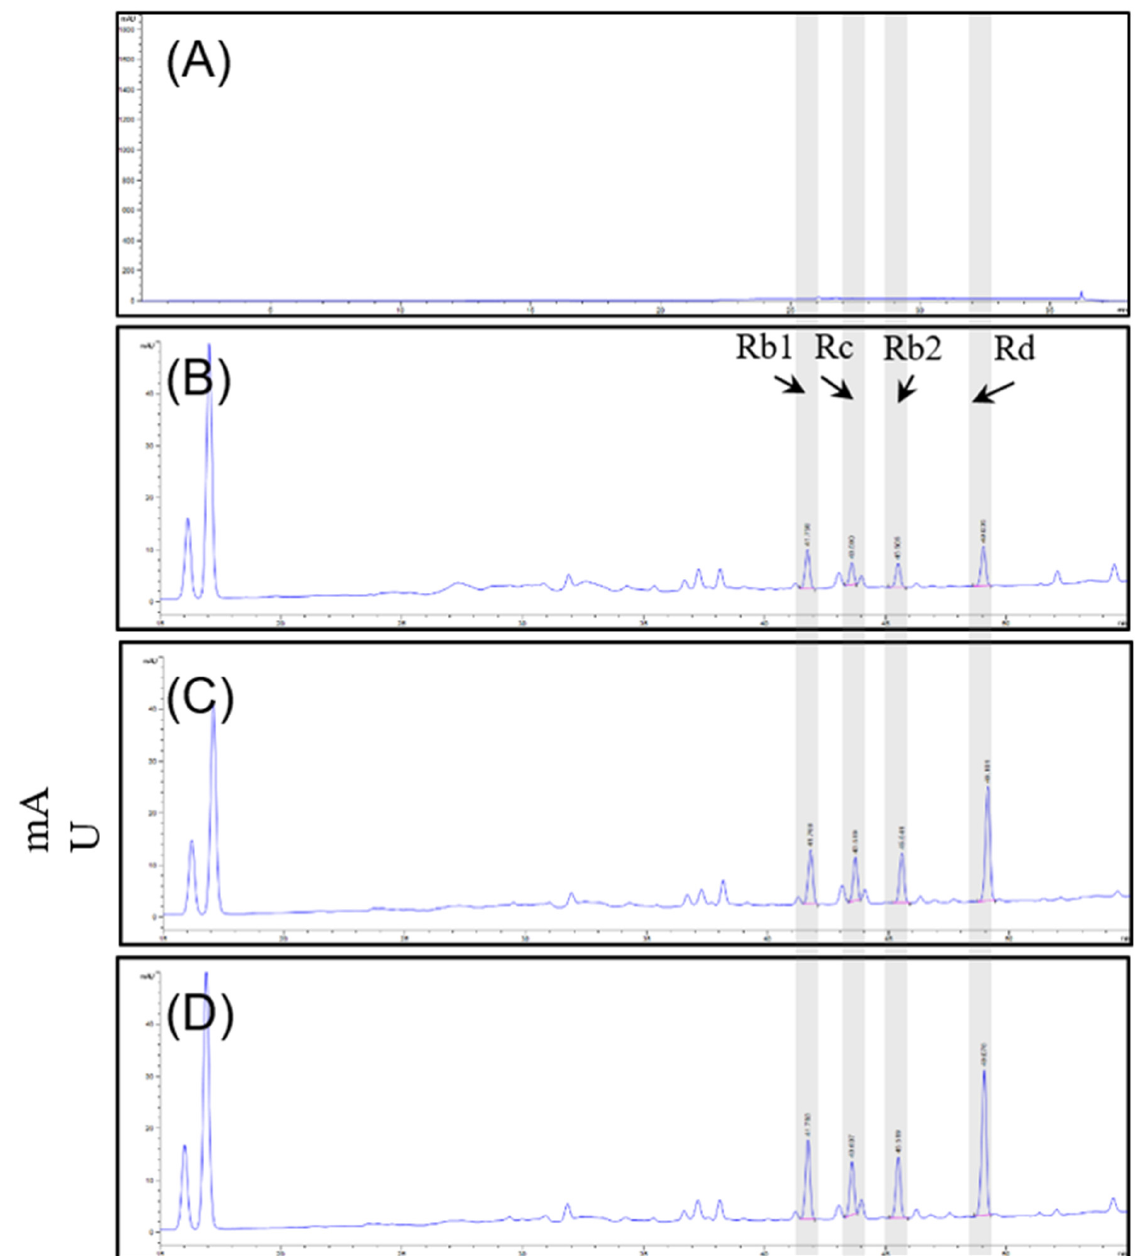
Figure 1. HPLC ‐ DAD chromatograms of ( A ) blank, ( B ) D1 extract, ( C ) D2 extract, and ( D ) S2 extract with excitation at 204 nm.